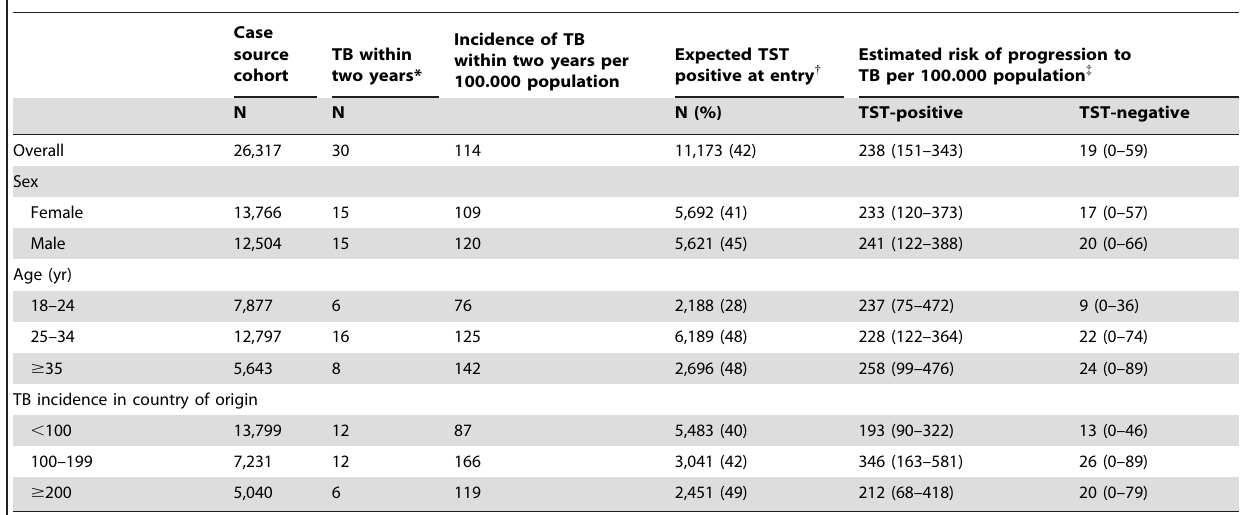
Table 3. Risk of progression to TB within two years after entry screening for TST $ 10 mm.